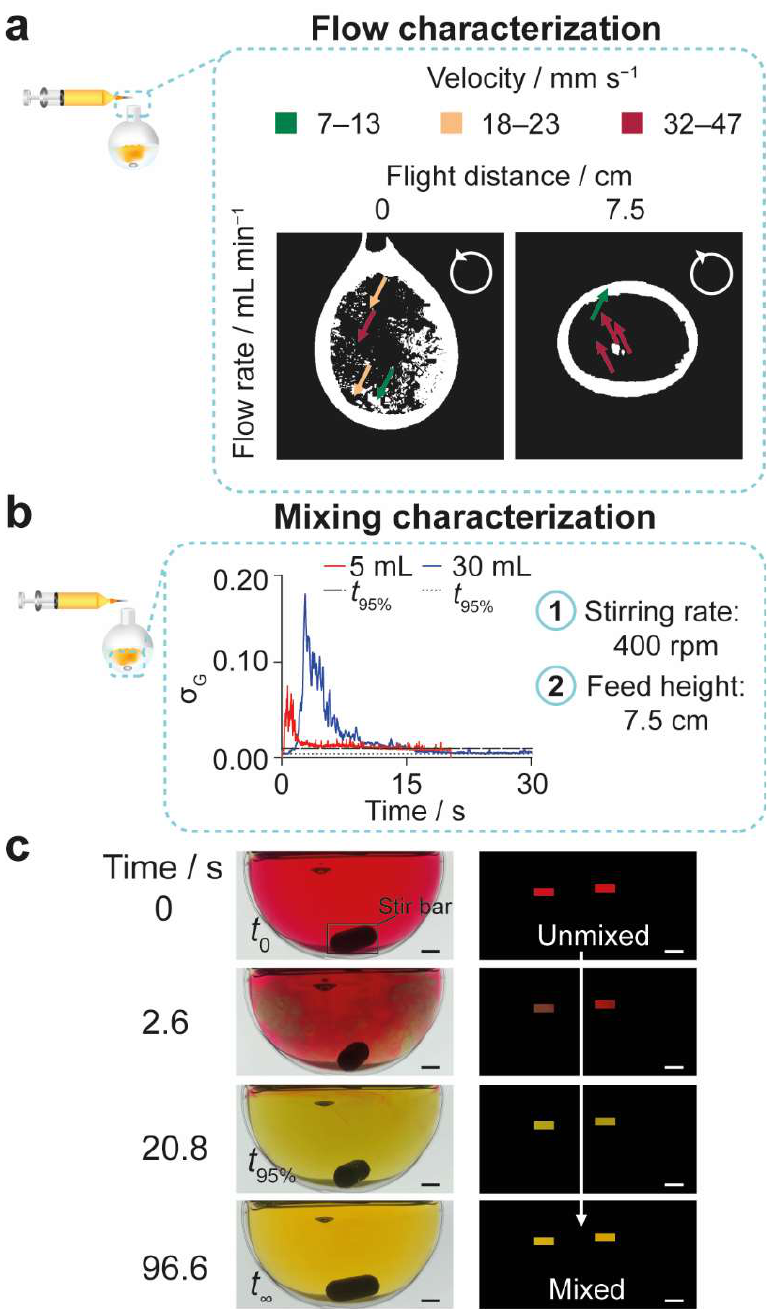
Figure 2. Exemplary characterization of the silk precursor droplet flow rate and the bulk mixing time in the open semi-batch system. ( a ) The droplets of silk precursor, spiked with iron oxide nanoparticles, showed circulatory flow when extruded from the 0.33-mm blunt needle at a flow rate of 1 mL min −1 . The processed binary images showed the circulatory flow field of silk precursor droplets at free-fall heights of 0 and 7.5 cm. Insets show the direction of flow in two dimensions. ( b ) The mixing time increased as the volume of antisolvent increased and was measured using the color change of a mixture of 4.3 × 10 −3 mg L −1 methyl red and 4.3 × 10 −3 mg L −1 thymol blue from acidic pH (red) to neutral pH (yellow). The variation in the standard deviation of the normalized green channel (σ G ) across the lower limits of the 6- and 36-mL volumetric scales in the open semi-batch system. ( c ) The raw and processed images showing the red to yellow color change observed using the DISMT method at the stirring rate of 400 rpm, feed height of 7.5 cm, and initial antisolvent volume of 30 mL. Scale bars = 5 mm.